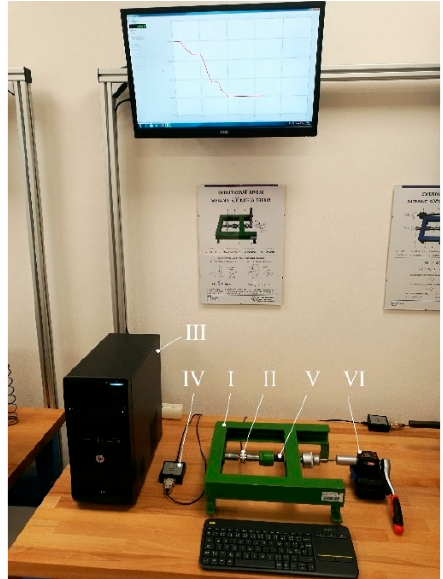
Figure 3. The stand designed for monitoring bolted joints during controlled loading: I—Basic struc- ture; II—membrane force sensor; III—computer; IV—A/D converter; V—tested screw; VI—torque measuring instrument.